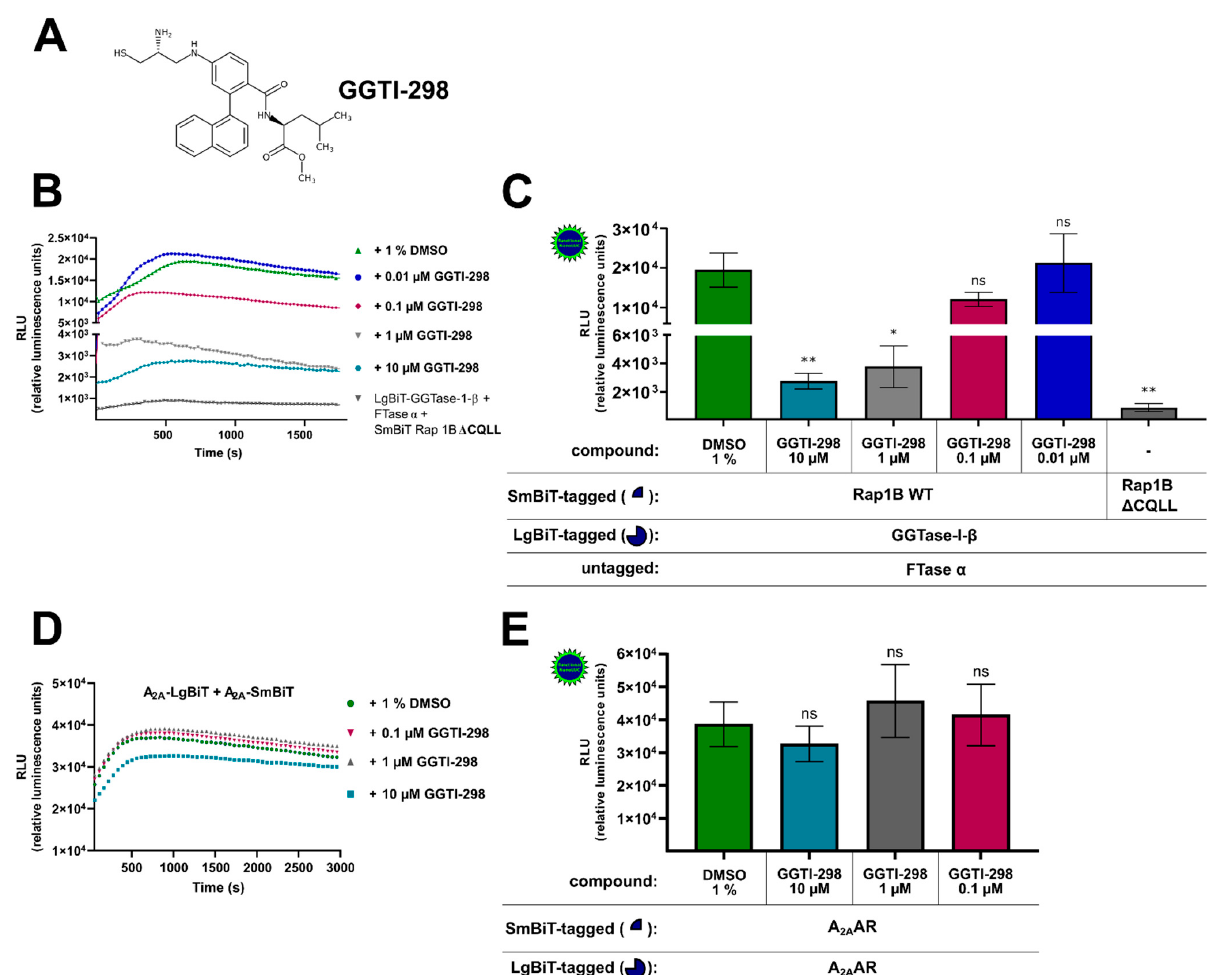
Figure 2. Effect of the cell-permeable, competitive CAAX (defined by a cysteine residue, two aliphatic residues, and the C -terminal residue) peptidomimetic GGTase-I inhibitor GGTI-298 on the interaction of GGTase-I and Rap1B and on A 2A AR-homodimers. HEK293 cells stably expressing the adenosine A 2B receptor (A 2B AR) were transiently co-transfected as described in Figure 1. From the Rap1B mutant, Δ CQLL 50 ng DNA/well was used. Additionally, for a control of the specificity of GGTI-298, HEK293 cells were transiently transfected with combinations of plasmids encoding LgBiT and SmBiT attached to the C -terminus of the human A 2A AR (each 100 ng DNA/well). ( A ) Structure of the cell-permeable, competitive CAAX peptidomimetic GGTase-I inhibitor GGTI-298. ( B ) Twenty-four hours after transfection, the cells were pre-treated for 30 min with the selective GGTase-I inhibitor GGTI-298 in different concentrations (10 µ M, 1 µ M, 0.1 µ M, 0.01 µ M) or with 1% DMSO at 37 ◦ C in OptiMEM medium. Then the NanoGlo live-cell substrate was added and the association was immediately monitored at 25 ◦ C over a time period of 30 min with a luminescence reading taken every 30 s. ( C ) After a time period of ~ 400–700 s the maxima of complex formation were reached (dependent on which GTI-298 concentration was used, see ( B ), and the relative luminescence units (RLU) were plotted. Significant differences were observed between the untreated LgBiT-GGTase-I- β /FTase α /SmBiT-Rap1B WT complex and the GGTI-298 inhibitor (10 µ M, 1 µ M) treated Lg-BiT-GGTase-I- β /FTase α /SmBiT-Rap1B complex (* p < 0.05, ** p < 0.01). ( D ) After 24 h the A 2A AR transfected HEK293 cells were pre-treated for 30 min with the selective GGTase-I inhibitor GGTI-298 in different concentrations (10 µ M, 1 µ M, 0.1 µ M) or with 1% DMSO at 37 ◦ C in OptiMEM medium. Then the NanoGlo live-cell substrate was added, and the association was immediately monitored at 25 ◦ C over a time period of 50 min, with a luminescence reading taken every 30 s. ( E ) After a time period of ~ 1005 s, the maxima of A 2A AR-homodimer formation were reached, and the relative luminescence units (RLU) were plotted. No significant differences were observed between the untreated A 2A -LgBiT/A 2A -SmBiT homodimer and the GGTI-298 inhibitor (10 µ M, 1 µ M, 0.1 µ M) treated A 2A -LgBiT/A 2A -SmBiT homodimer (ns, not